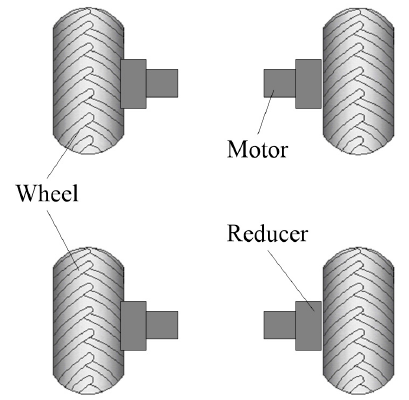
Figure 2. Driving mode of the wheel drive.